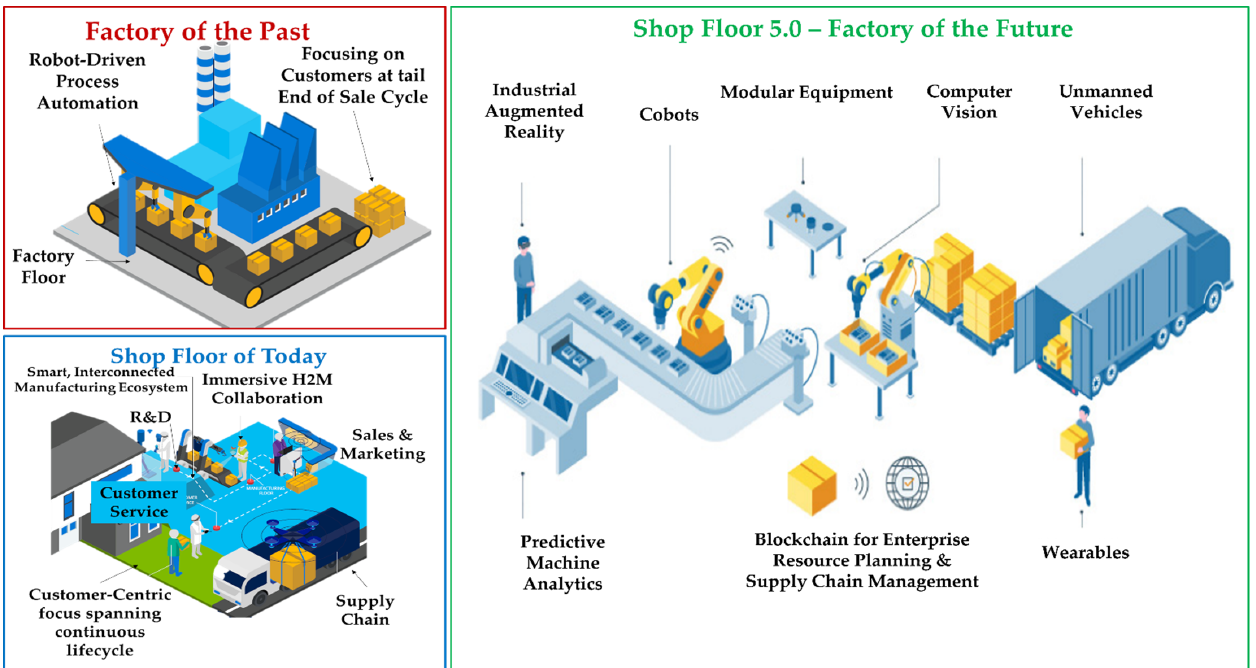
Figure 12. Towards Shop Floor 5.0 (derived from [68]).